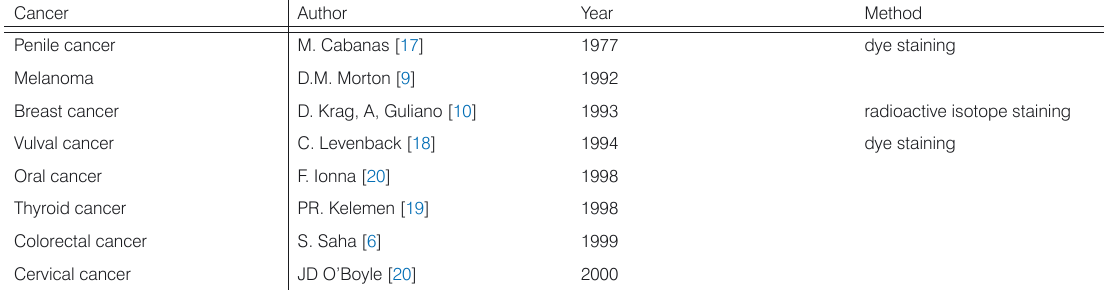
Table 3. Chronology of the studies on clinical application of SNLB in several cancers.